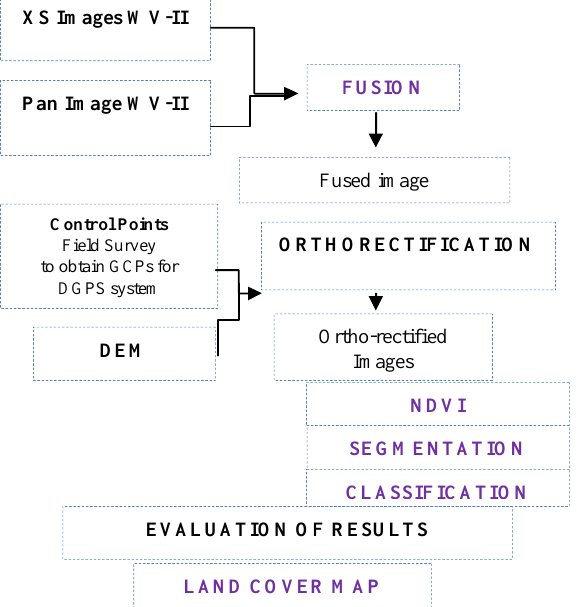
Figure 4 – Methodological